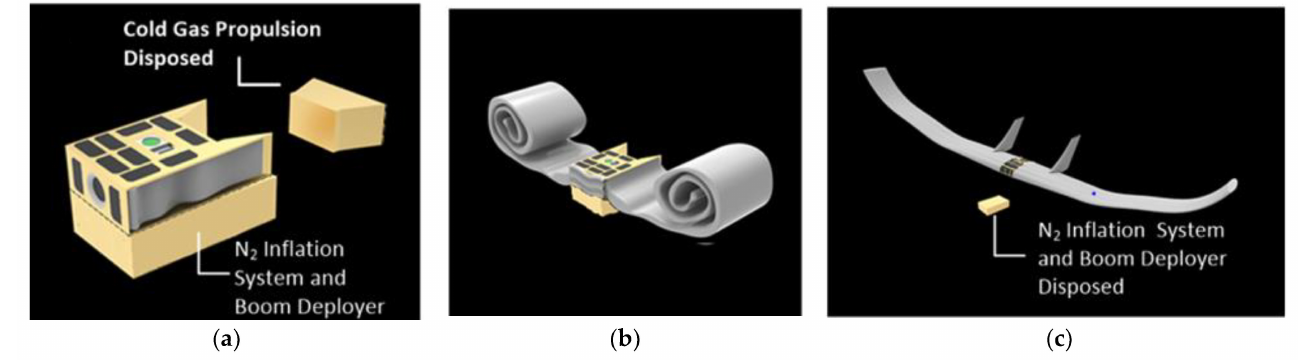
Figure 13. Mars sailplane deployment steps. ( a ) The cold-gas propulsion is used to achieve a separation distance; ( b , c ) Wing deployment begins.